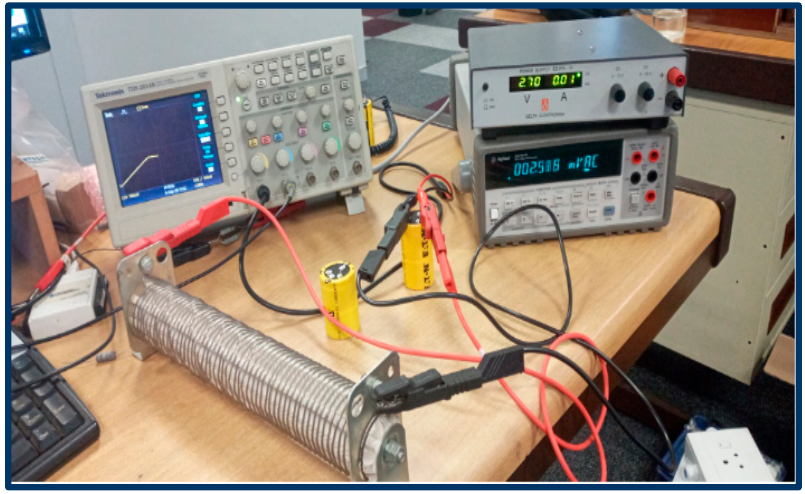
Figure 3. Experimental setup.